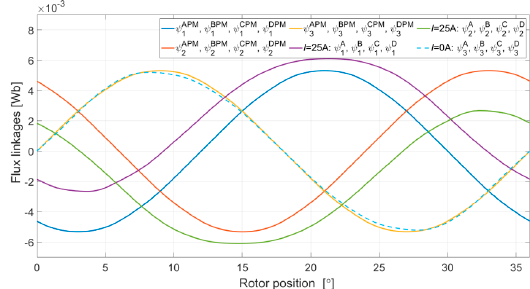
Figure 6. Flux linkages vs. rotor positions for QCO —variant I.